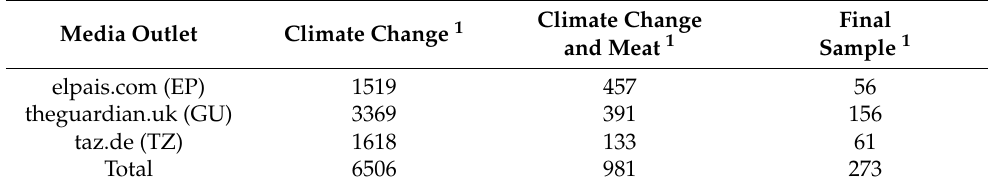
Climate Change Final and Meat 1 Sample 1